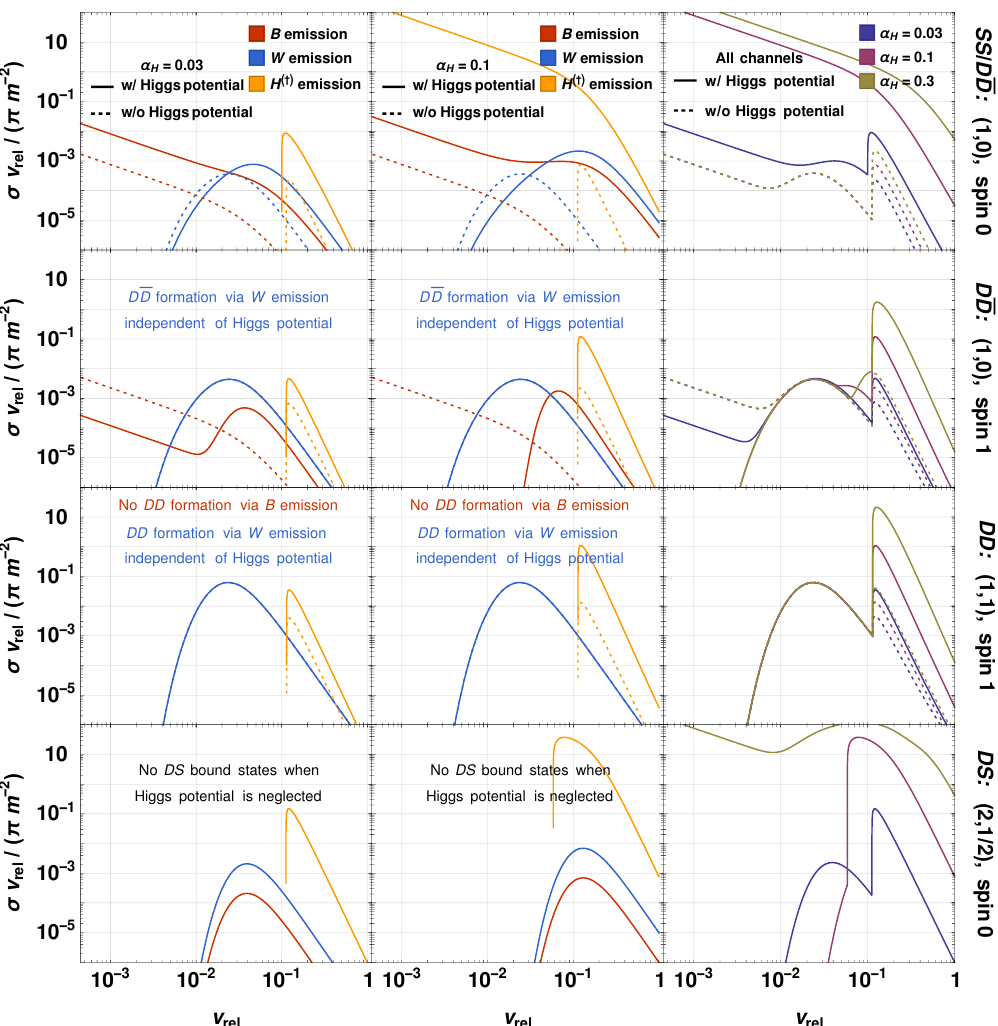
Figure 9 . The radiative BSF cross-sections vs relative velocity. The four rows correspond to capture into the ground levels of the bound states marked on the right. In the DD and DS panels, we have included the capture into the conjugate bound states, and all BSF channels have been weighted with the number of DM particles eliminated in each process as estimated upon thermal averaging (cf. ref. [28]). Left and middle columns : the contributions of B , W and H ( † ) emission, for α = 0 . 03 and 0 . 1 . Comparing with figure 3 at v 0 . 1 relevant for DM freeze-out, rel ∼ H BSF can be comparable to or significantly faster (in the case of H ( † ) emission) than annihilation, σ ann v rel / ( πm − 2 ) ∼ 10 − 3 . Right column : the sum of the B -, W - and H ( † ) -emission contributions, for different values of α . In both columns, we show the cross-sections considering and neglecting H the Higgs-mediated potential. The various σv normalised to πm − 2 are independent of the DM rel mass, except for the cutoff on BSF via H ( † ) emission due the Higgs mass; for this purpose, we have used m = 50 TeV and temperature T = 300 GeV which sets m ’ 168 GeV. Note that we take the H Higgs potential to be Coulombic (see text for